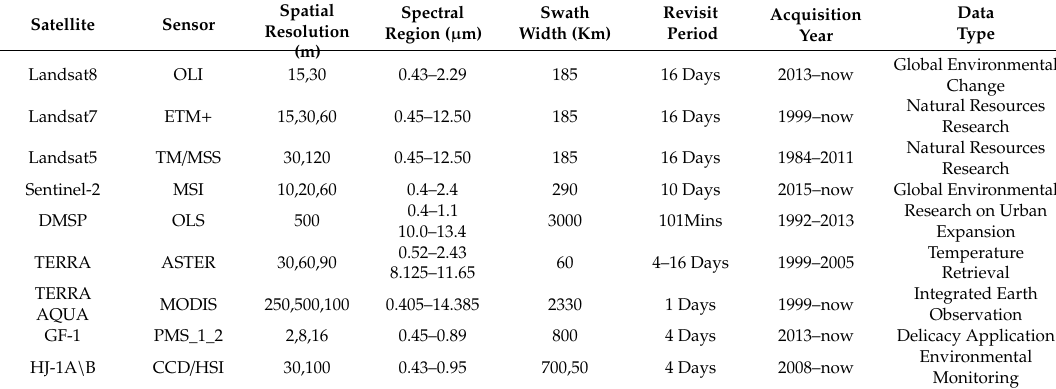
Table 2. Source datasets of metadata for experiment. Defense Meteorological Satellite Program